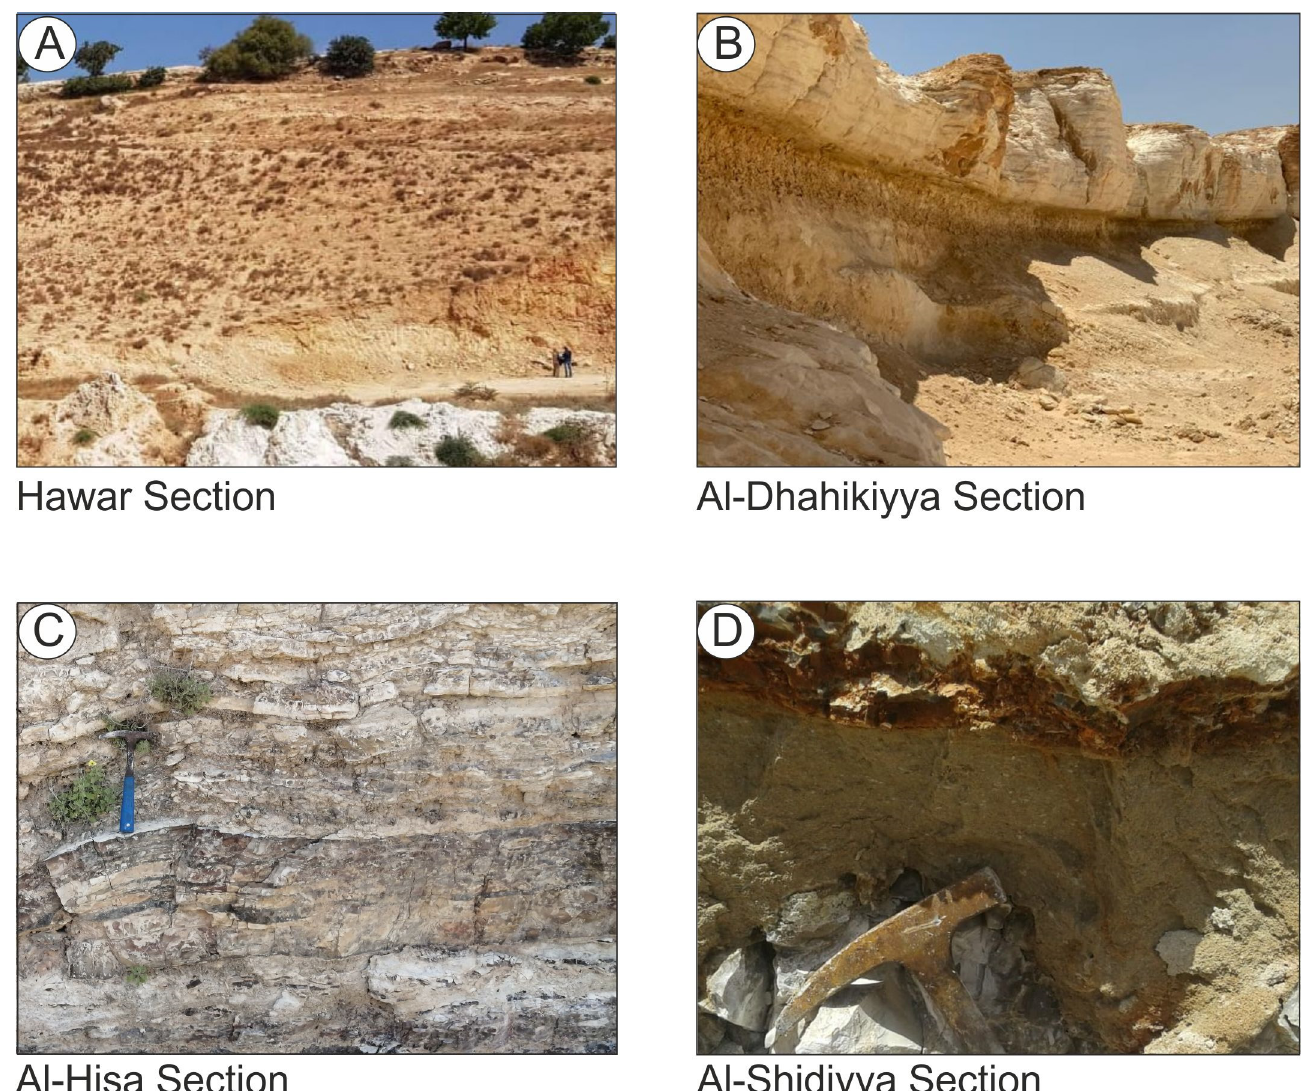
Figure 2. A field photos of ( A ) the lower part of section 1, ( B ) section 2, ( C ) the main bed in section 3, ( D ) The A3 horizon in section 4.